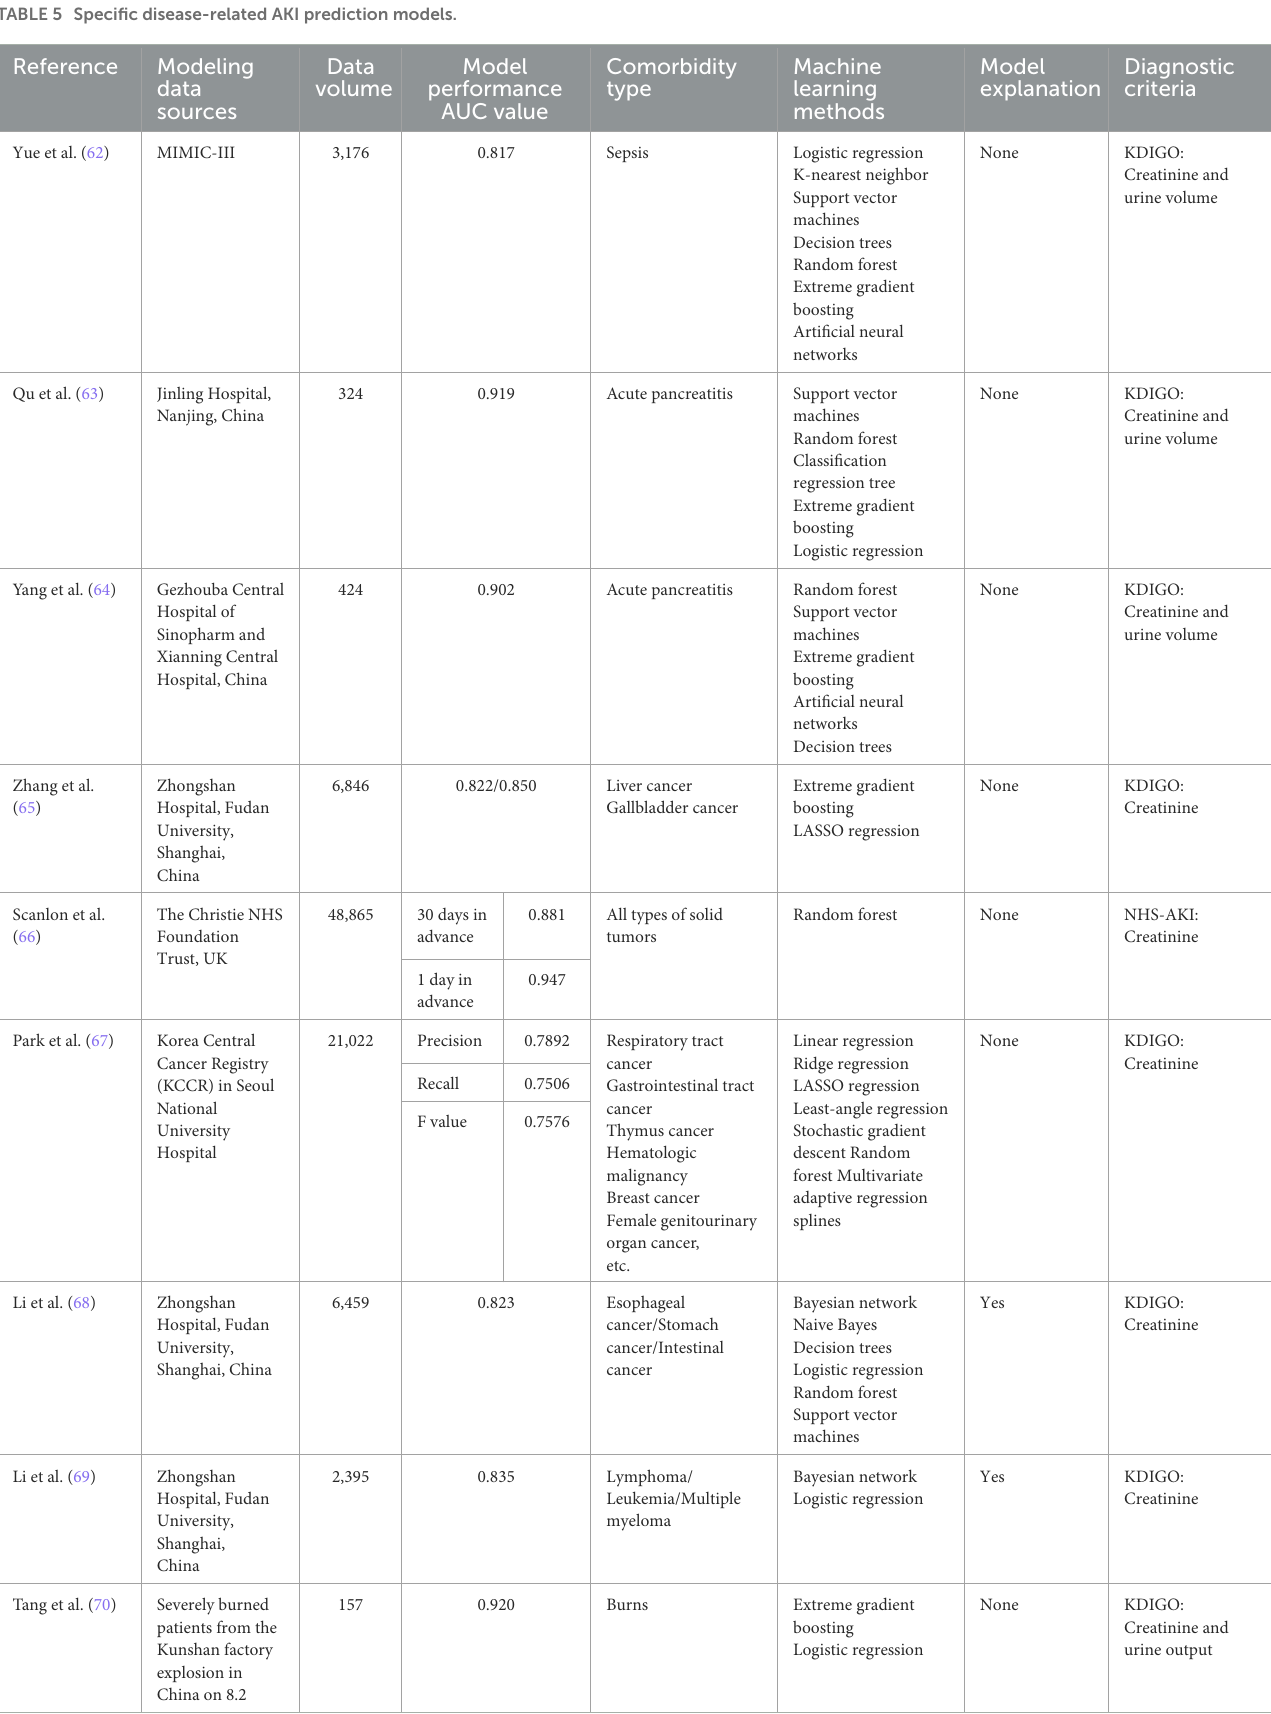
TABLE 5 Specific disease-related AKI prediction